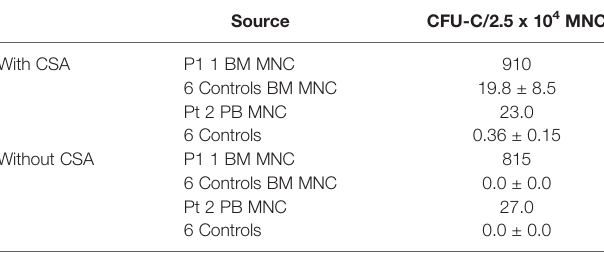
TABLE 2 | Myeloid colony formation in patients with CMML.